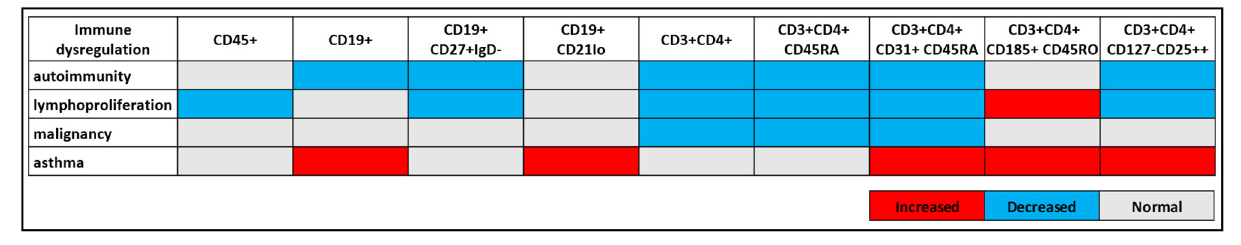
FIGURE 3 | The distribution of out-of-range absolute counts of B and T lymph cell subsets, total CD45 + lymph cells, total CD19 + B cells, CD19 + CD27 + IgD– switched memory B cells, CD19 + CD21lo immature B cells, CD3 + CD4 + T helper cells, CD3 + CD4 + CD45RA naive T helper cells, CD3 + CD4 + CD31 + CD45RA recent thymic emigrants, CD3 + CD4 + CD185 + CD45RO follicular T helper cells, and CD3 + CD4 + CD127–CD25 ++ T regulatory cells, in immune dysregulation